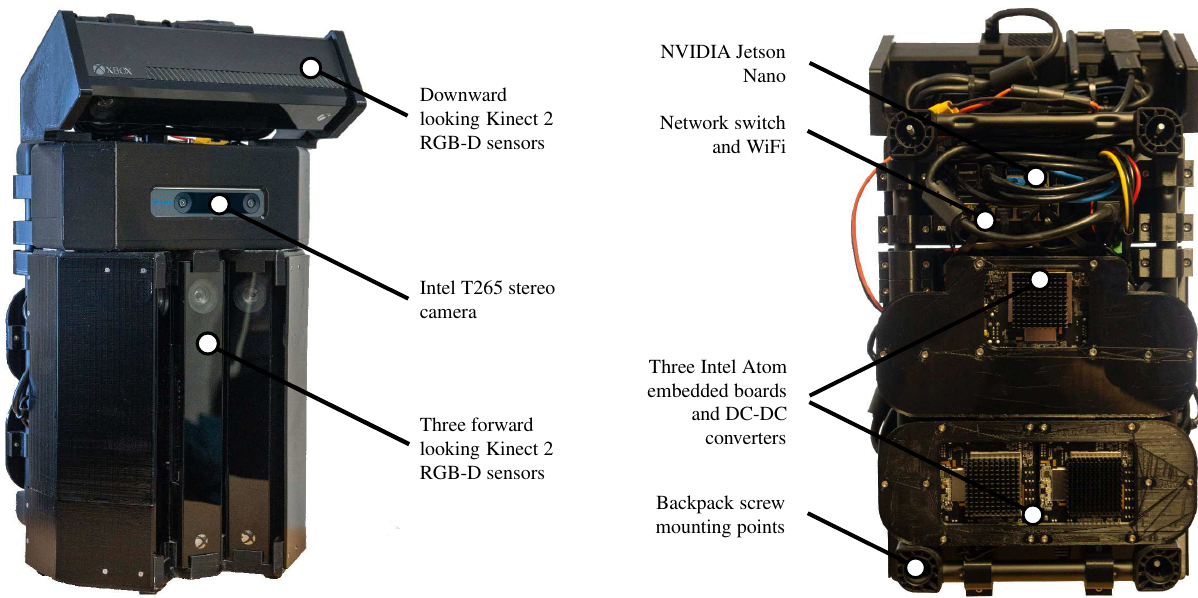
Figure 2. Detail view of the backpack system and its components. Left: Three forward looking Kinects capture the opposite wall and the area directly behind the backpack. An additional downward looking Kinect ensures a reliable detection of the ground. In the center is an Intel Realsense T265 stereo camera for visual-inertial odometry. Right: On the back of the backpack the embedded computing boards for data capture and processing, networking and power supply components are